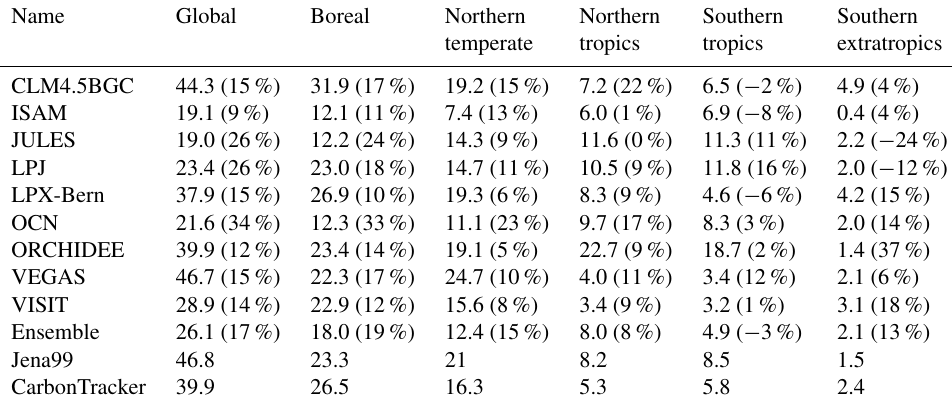
Table 4. The seasonal amplitude (maximum minus minimum, in PgCyr − 1 ) of mean net carbon flux for 2001–2010 relative to the 1961–1970 period, according to the nine TRENDY models (values are listed as percentage change in brackets, for both regions and the entire globe). The four large latitudinal regions are the same as in Fig. 3: boreal (50–90 ◦ N), temperate (23.5–50 ◦ N), northern tropics (0–23.5 ◦ N), southern tropics (0–23.5 ◦ S) and southern extratropics (23.5–90 ◦ S). Values from the two inversions, Jena99 and CarbonTracker, are also listed for